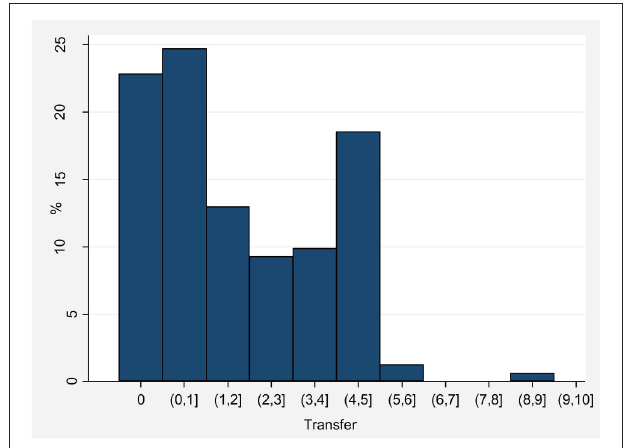
FIGURE 2 | Number of subjects per transfer interval in the Dictator Game.